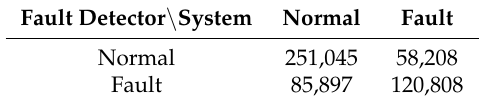
Figure 12. Example of a detection fault f ( k ) , compared with the manipulated fail b f ( k ) , for: ( a ) ARX model; ( b ) DDM; ( c ) SDM; and, ( d ) Hammerstein-Wiener model. Figure 14: The proposed method consists in transmitting a frame using ⌈ α n cha ⌉ channel uses for the fi rst transmission attempt, with 0 < α ≤ 1 . In the event of a decoding error, incremental redundancy is transmitted 1 − α n cha ⌋ channel uses. making use of the rest of the available ⌊ ( ) Table 5. Confusion matrix for fault detection, based on simple-diode model and an adaptive threshold.